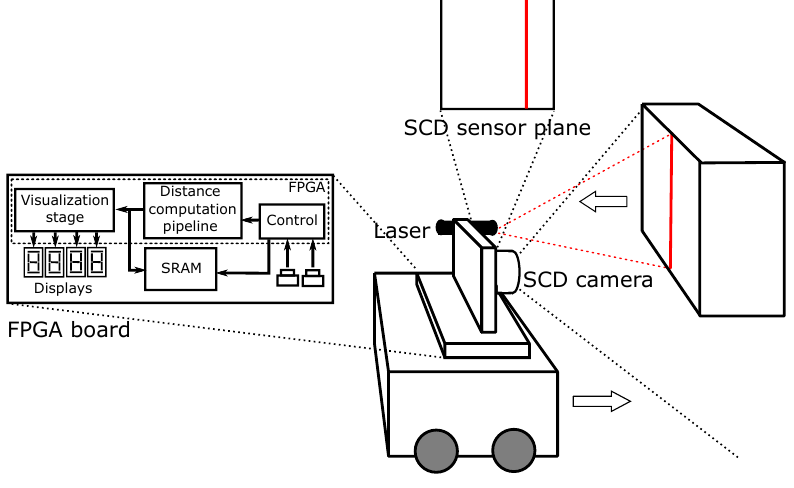
Figure 1. Motion detection